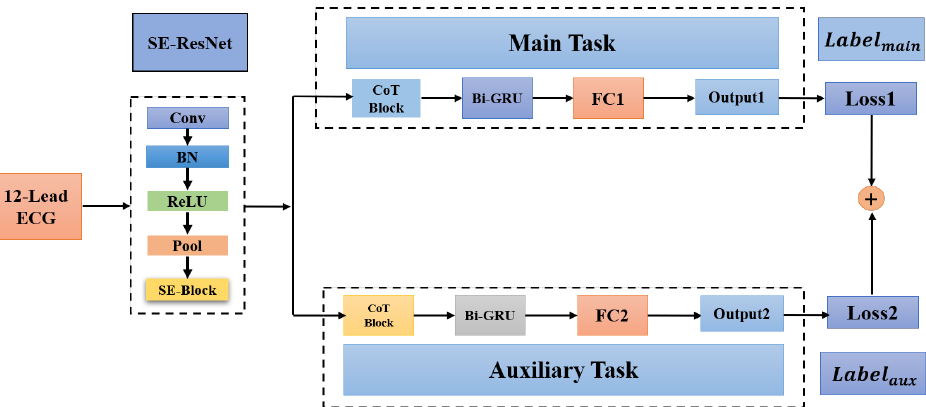
Figure 1. Multi-task neural network. FC1 and FC2 are fully connected layers used in the main task and the auxiliary task,